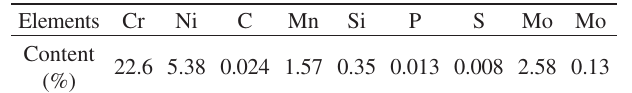
Table 1. Chemical composition of the DSS, wt. (%). Elements Cr